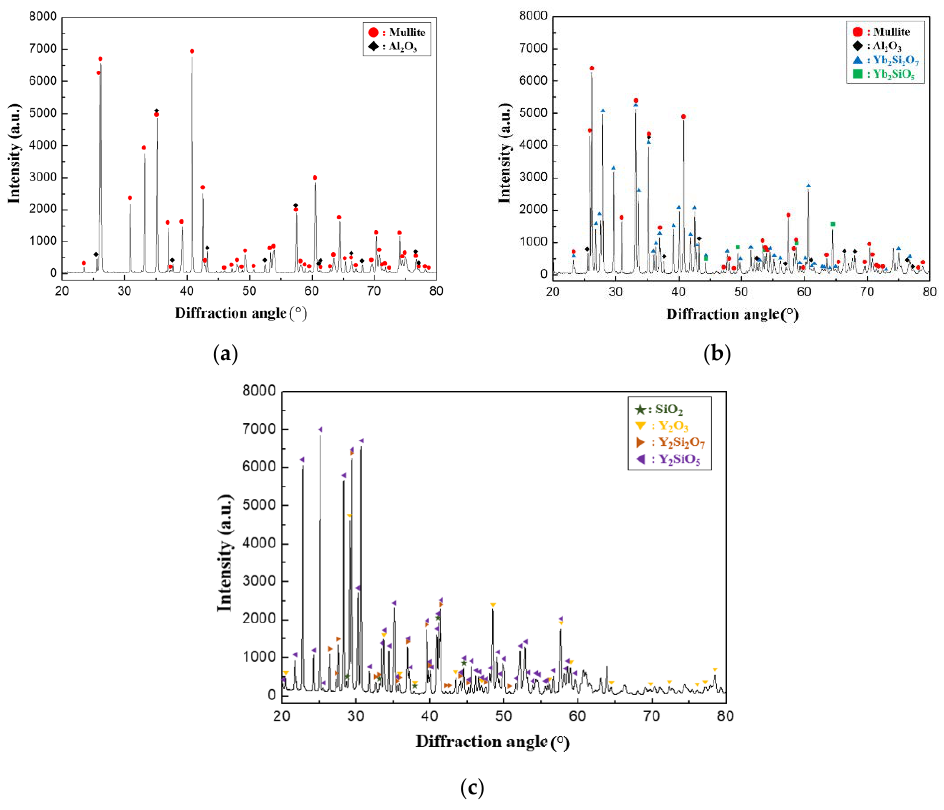
Figure 9. XRD patterns of ( a ) mullite, ( b ) mullite + Yb 2 SiO 5 , and ( c ) Y 2 SiO 5 after 5000 thermal shock cycles at 1350 °C.